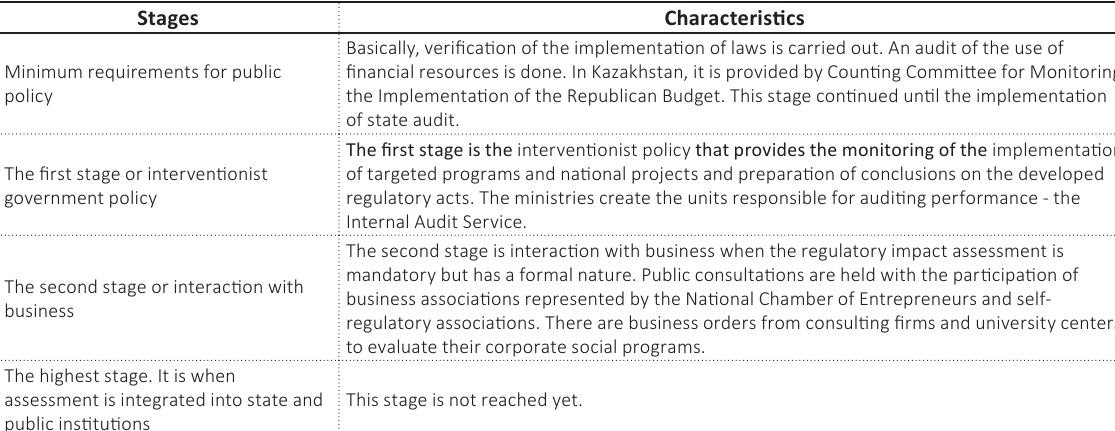
Table 1. Stages of development of public management in